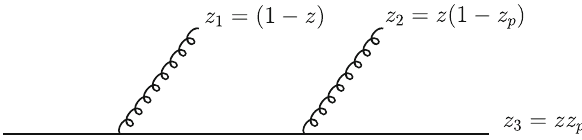
Fig. 1 An illustration of the parameterisation used for kinematic vari- ables in the gluon emission process, relevant to the triple-collinear limit calculation discussed in the main